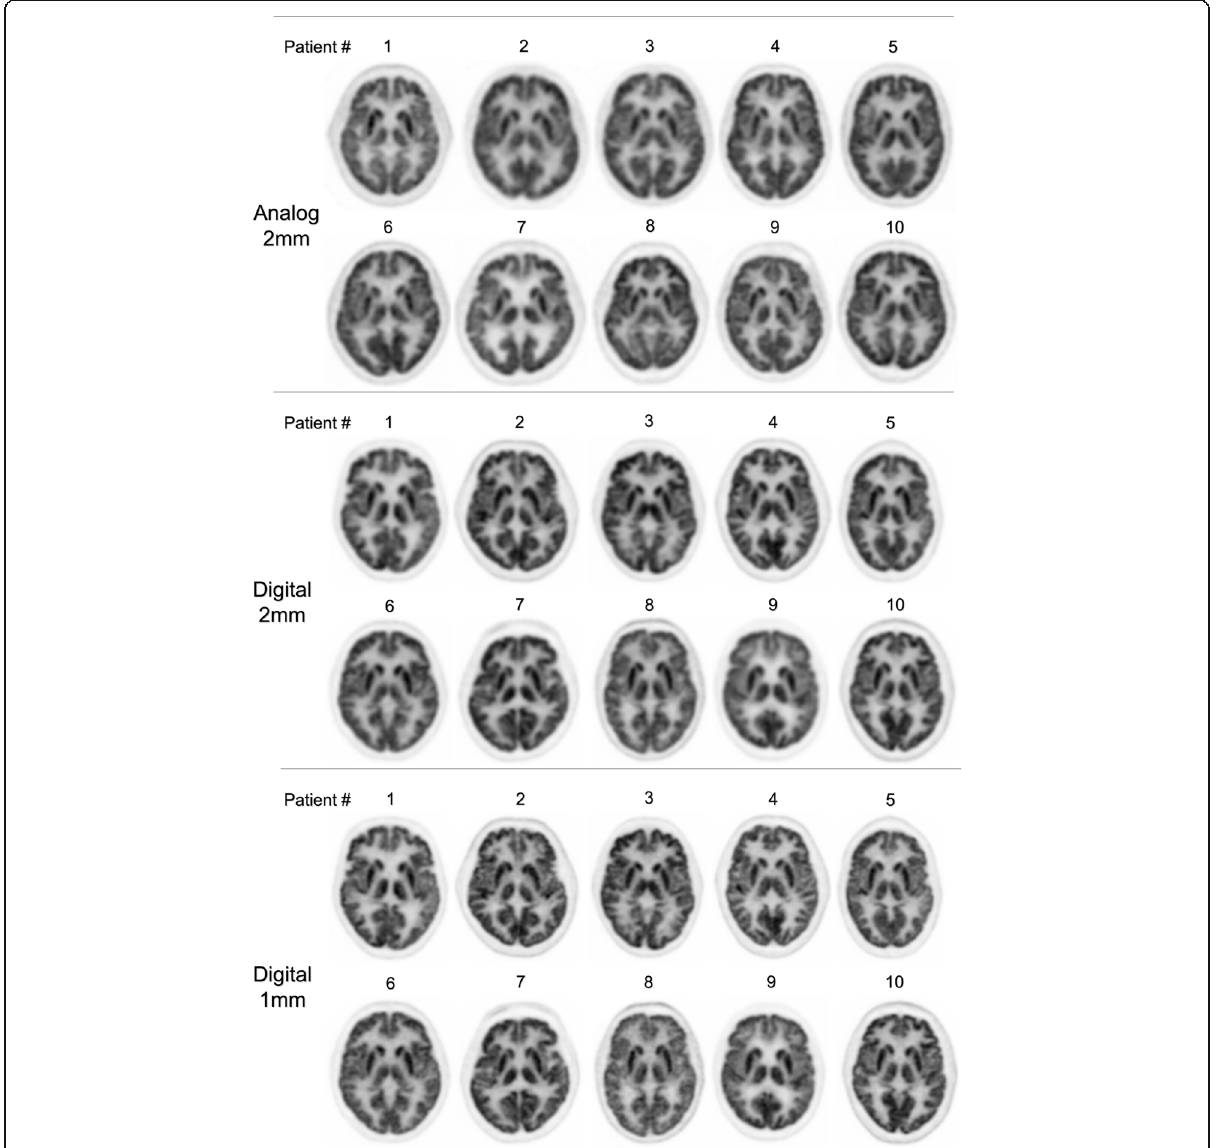
Fig. 4 Gallery of axial brain 18 F-FDG PET images obtained with analog PET and a current reconstruction method using a 2-mm voxel size ( n = 10) (upper row), with digital PET and either a comparable reconstruction method with 2-mm voxel size ( n = 10) (middle row) or a high-resolution reconstruction method with 1-mm voxel size ( n = 10) (lower